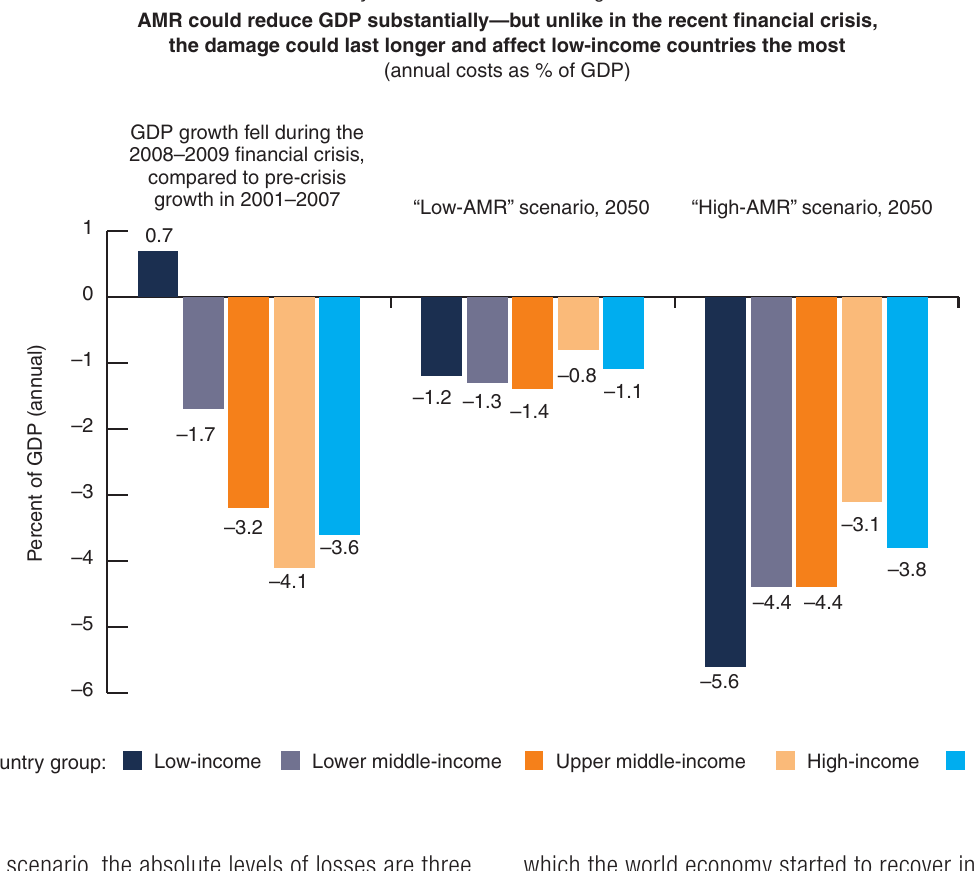
FIGURE 3. Economic Costs of AMR May Be as Severe as During the Financial